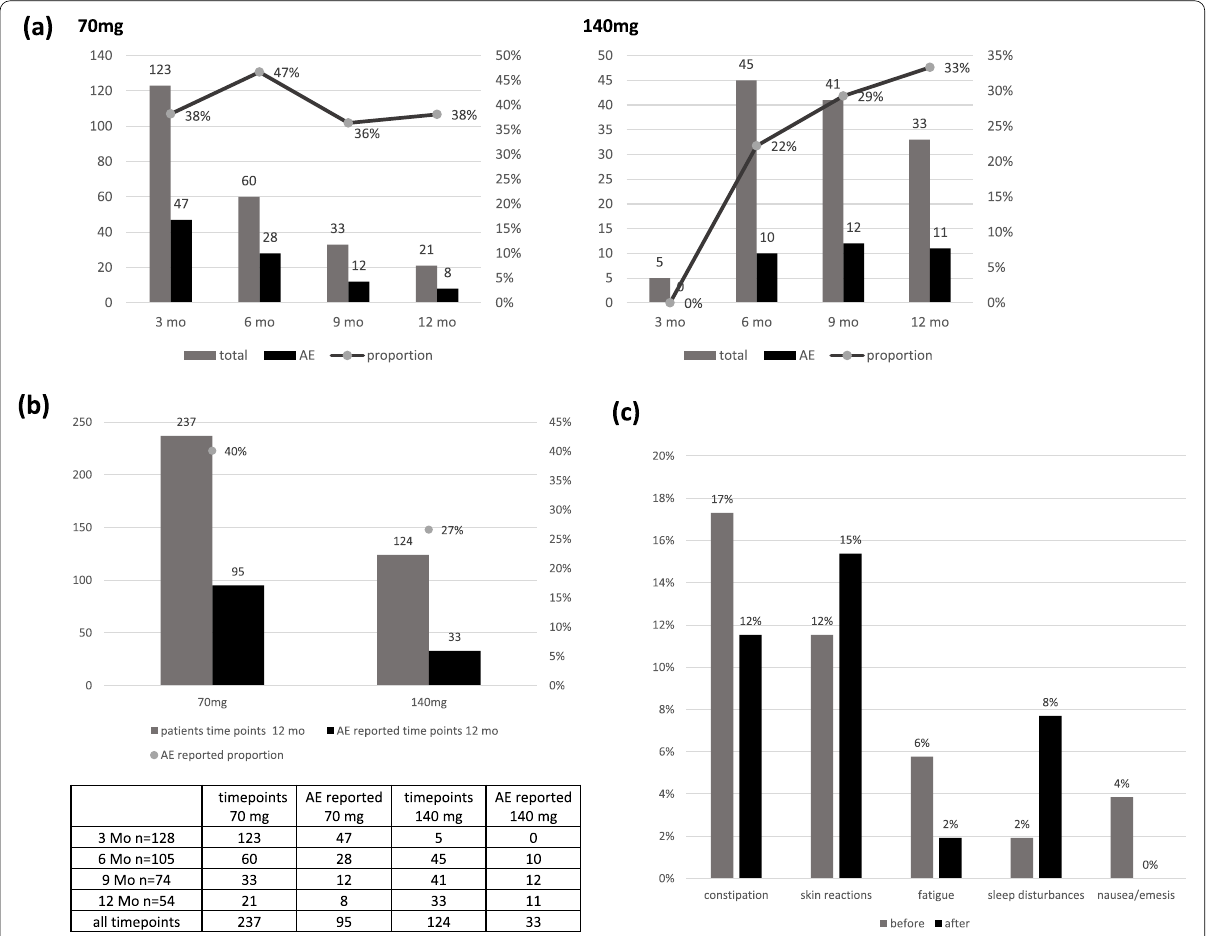
Fig. 2 Cumulative dose-related adverse events. Reported AEs with 70 mg or 140 mg erenumab per month (a), cumulative timepoints and timepoints with reported AEs depending on the respective dosage over the therapy up to 12 months (b). Reported AEs before and after